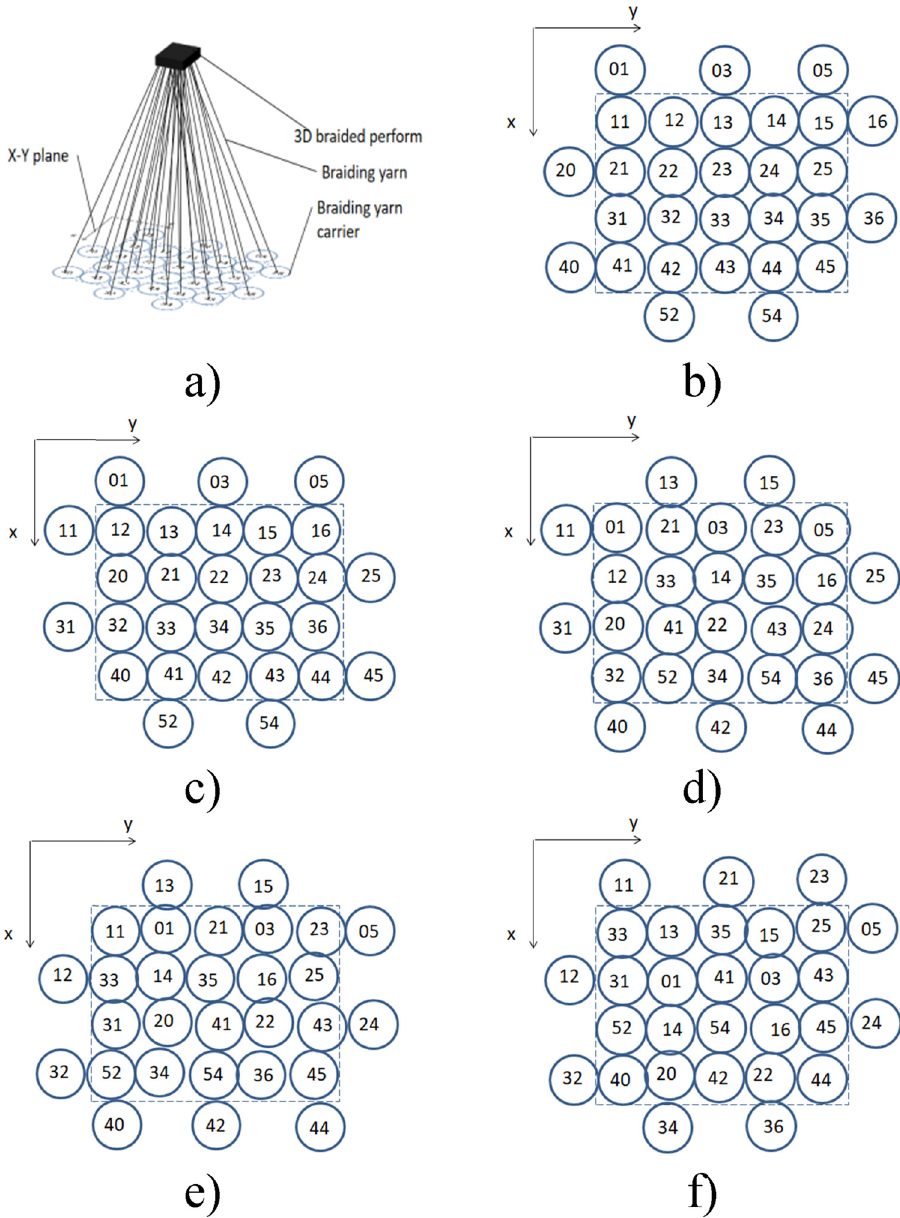
Figure 9: Schematic diagram of the weaving process of the preform, ( a ) braid arrangement and forming, ( b ) initial state, ( c ) fi rst step, ( d ) second step, ( e ) third step, ( f ) fourth